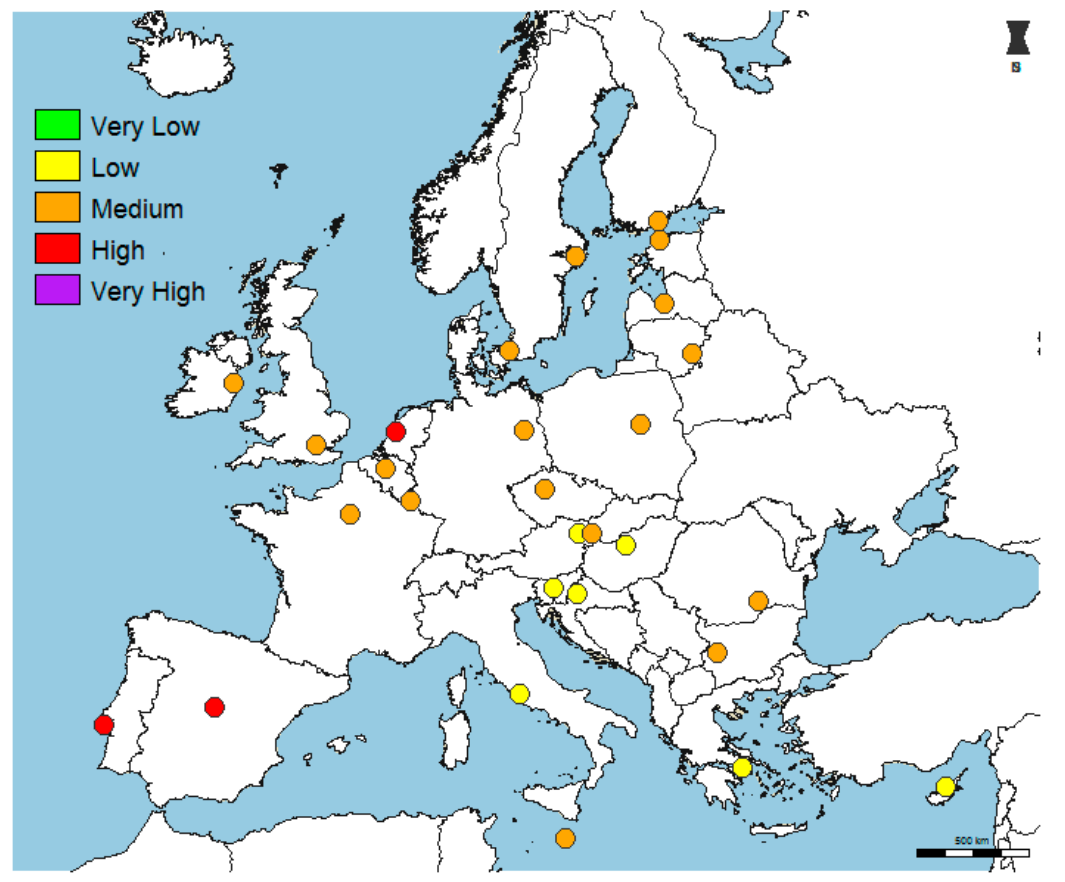
Figure 1. The risk levels of the Heatwave Hazard Index (HWHI) in the capitals of the 28-EU Member States during the 18-year sub-period 1980–1997. The color keys indicate the five HWHI risk-levels.